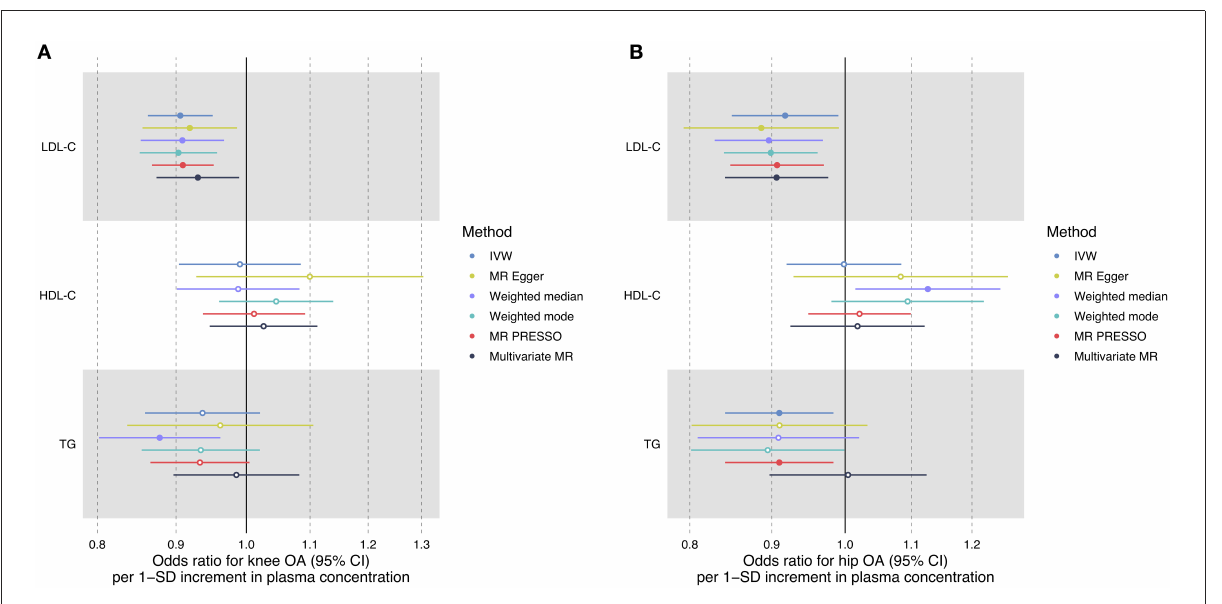
FIGURE2 Forest plot comparing causal effect estimates of serum lipid levels on knee (A) and hip (B) OA risk using univariate and multivariable MR analyses. Odds ratios (ORs) with 95% confidence intervals (CIs) are scaled to 1-SD increment in blood lipid